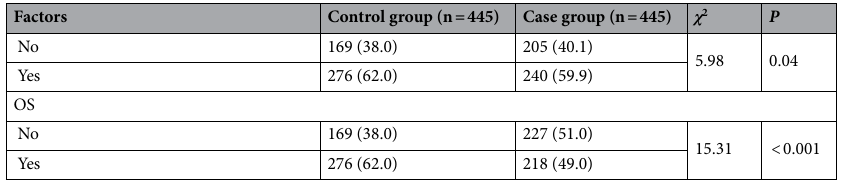
Table 2. Comparison of basic characteristics and physical health status between the case group and the control group [n(%)]. a Chi-square test of trend. b The Quit smoking Group was smaller and was incorporated into the smoking group. c The Alcohol withdrawal Group was smaller and was incorporated into the drinking group.